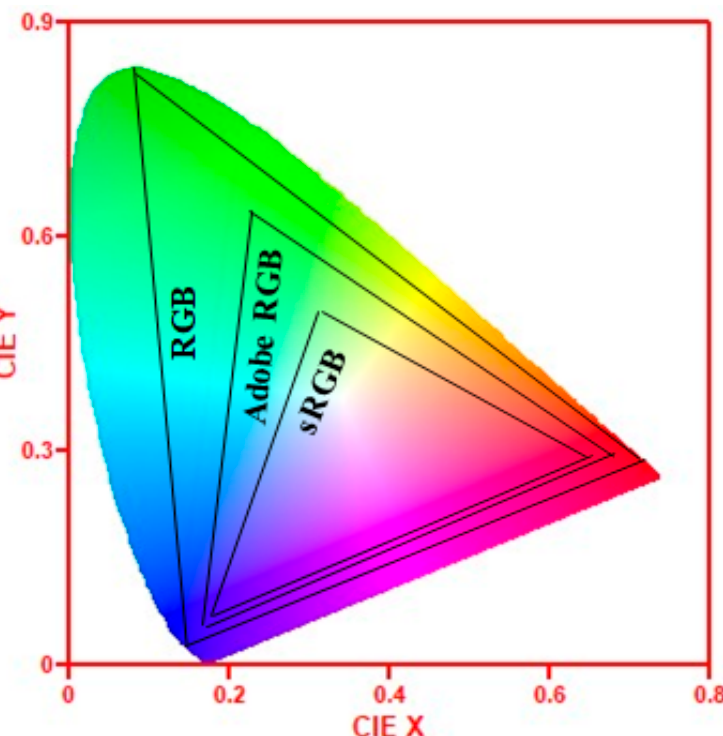
Figure 2. Three triangle chromaticity diagram of CIE 1931 showing the color gamut of RGB, Adobe RGB, and